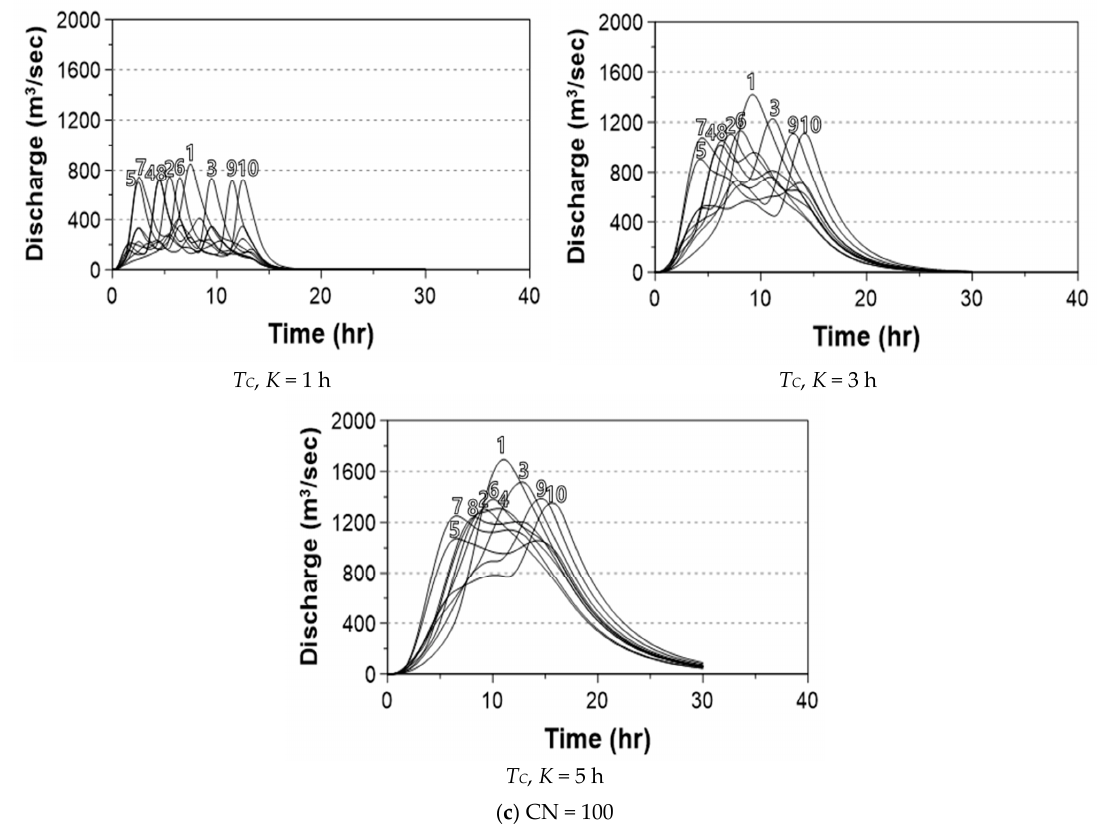
Figure 10. As for Figure 7, but with the randomly distributed rainfall histograms in Figure 9.